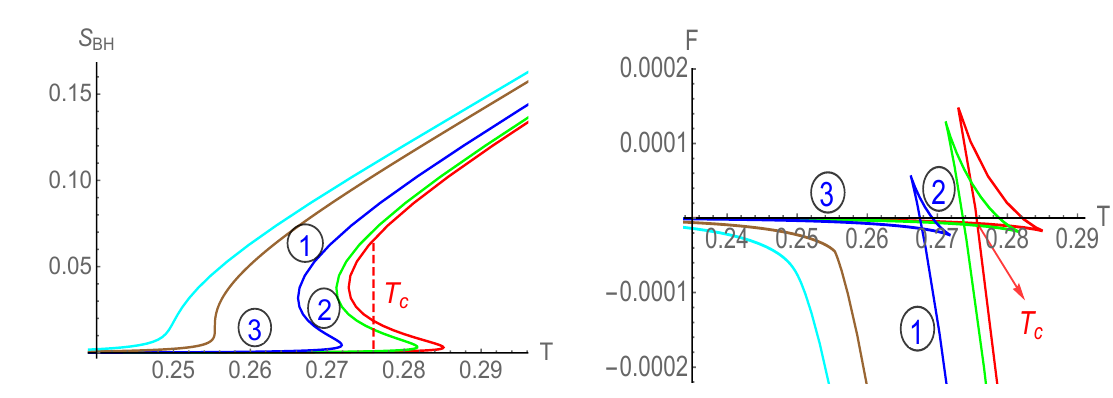
Figure 23 . Bekenstein-Hawking entropy as a function of T for various values of (cid:22) . Here red, green, blue, brown and cyan curves correspond to (cid:22) = 0, 0 : 1, 0 : 2, 0 : 312 and 0 : 35 respectively. In units GeV.